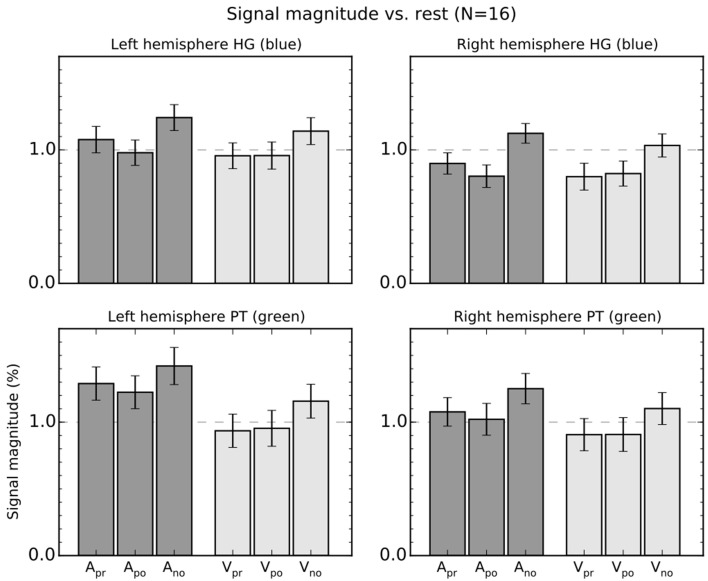
Percentage signal magnitude in the left and right hemisphere planum temporale (PT) and Heschl's gyrus (HG) ROIs. The bars show mean (±SEM) ROI signal relative to rest. The colors in panel titles refer to ROIs shown in Figure 2C.